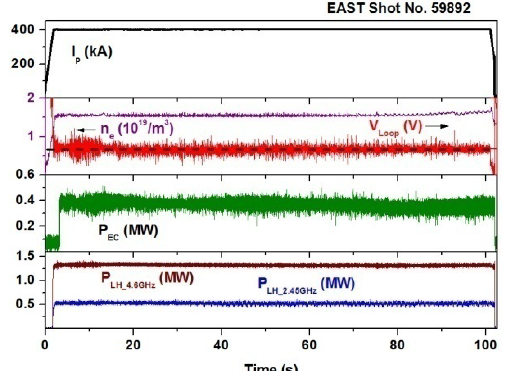
Fig. 13. Time evolution of the I p , n e , V loop , ECRH power, LHCD (4.6 GHz) power, and LHCD (2.45 GHz) power for the 102s high T e operation of